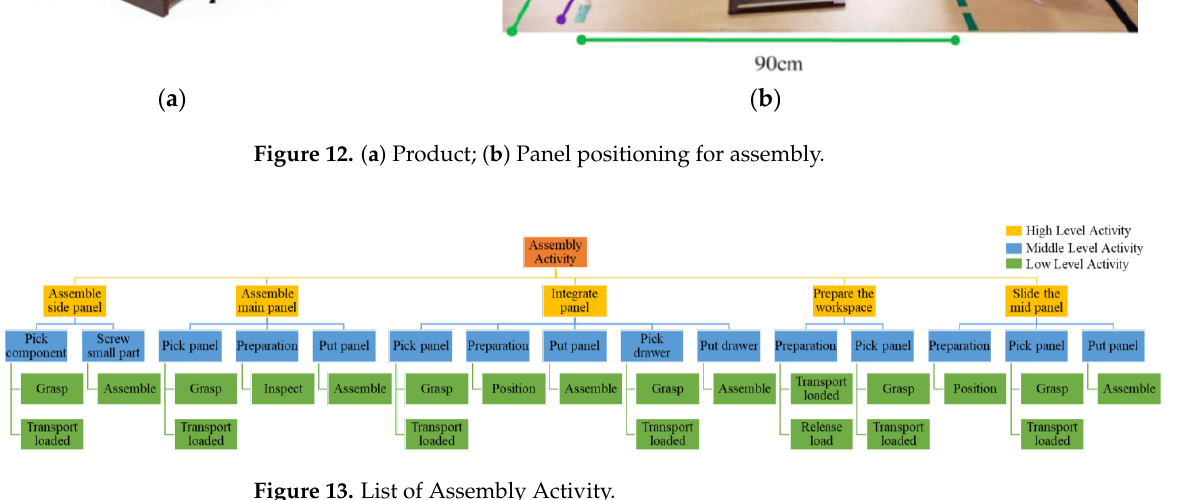
Figure 13. List of Assembly Activity.